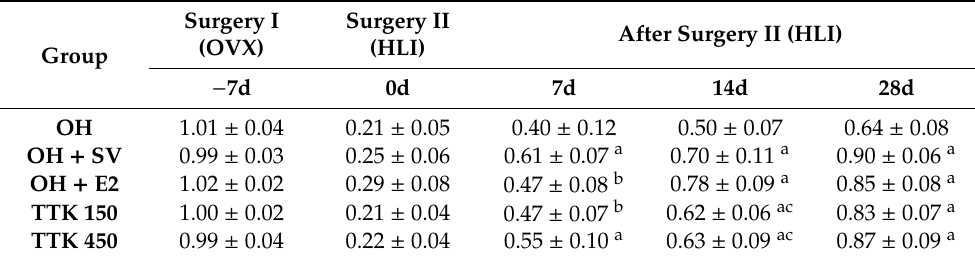
Table 2. Ischemic / non-ischemic blood flow